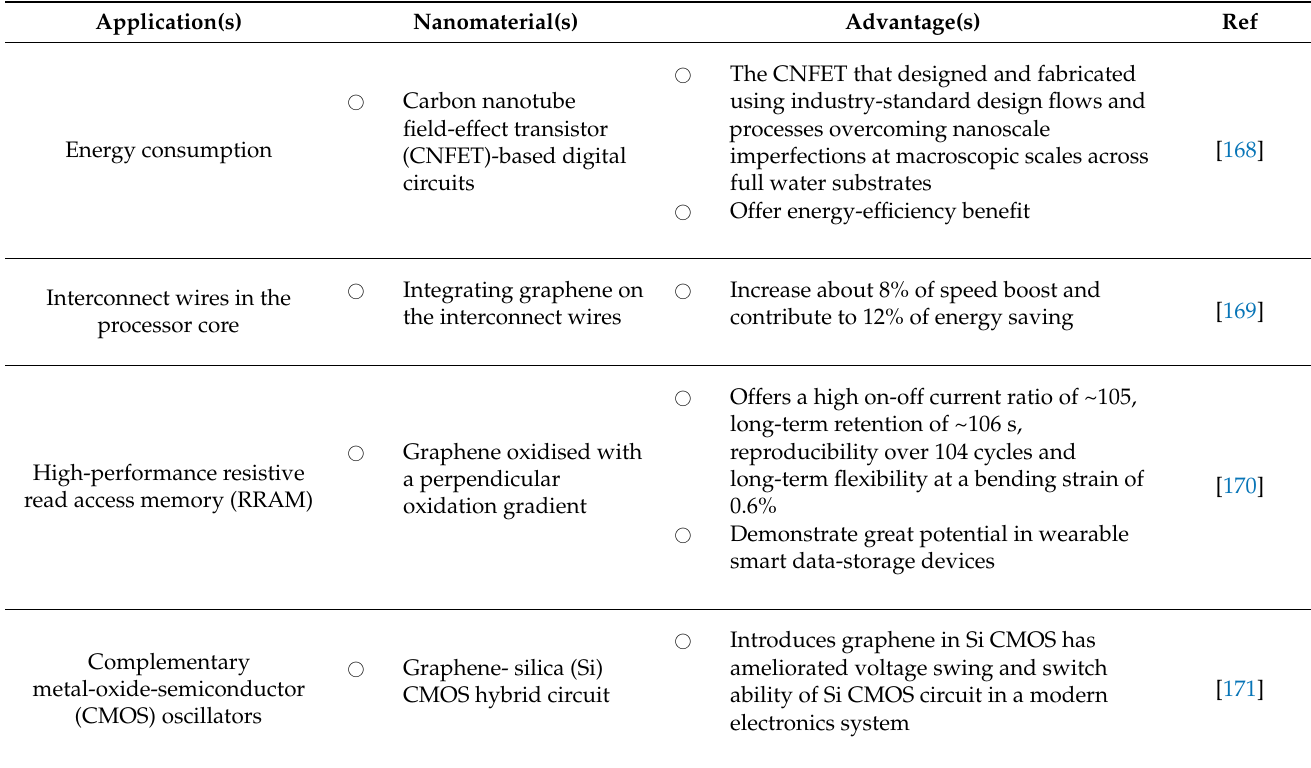
Table 5. Nanomaterials and selected applications of nanoprocessors for future biomedical applica- tions along with their